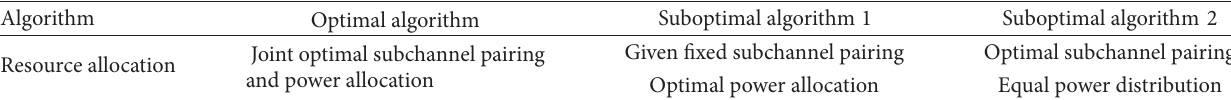
Table 1: Comparison of the proposed optimal algorithm and suboptimal